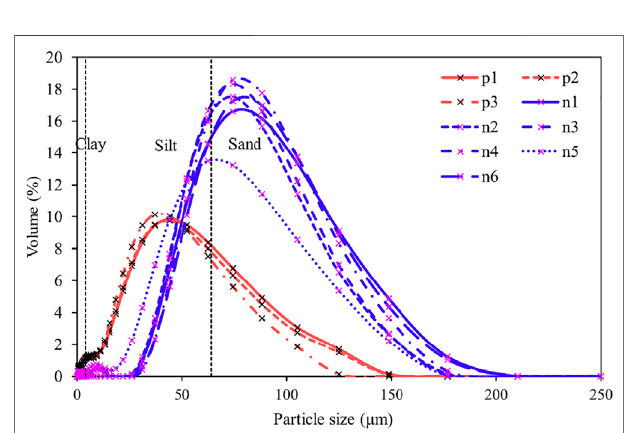
FIGURE7| Grainsizedistributioncurveofsedimentonerosionpatterns (red lines) and surrounding tidal fl at (blue lines).